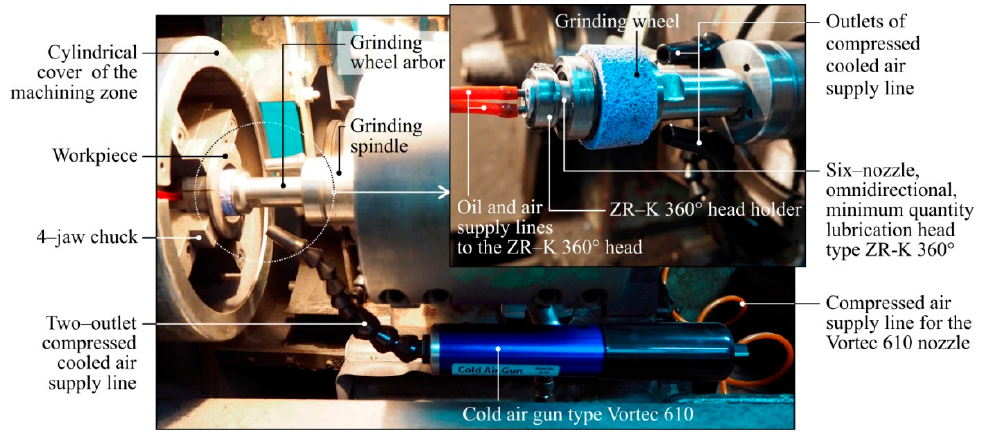
Figure 1. Overall view of the grinding zone with components of the centrifugal MQL-CCA system.